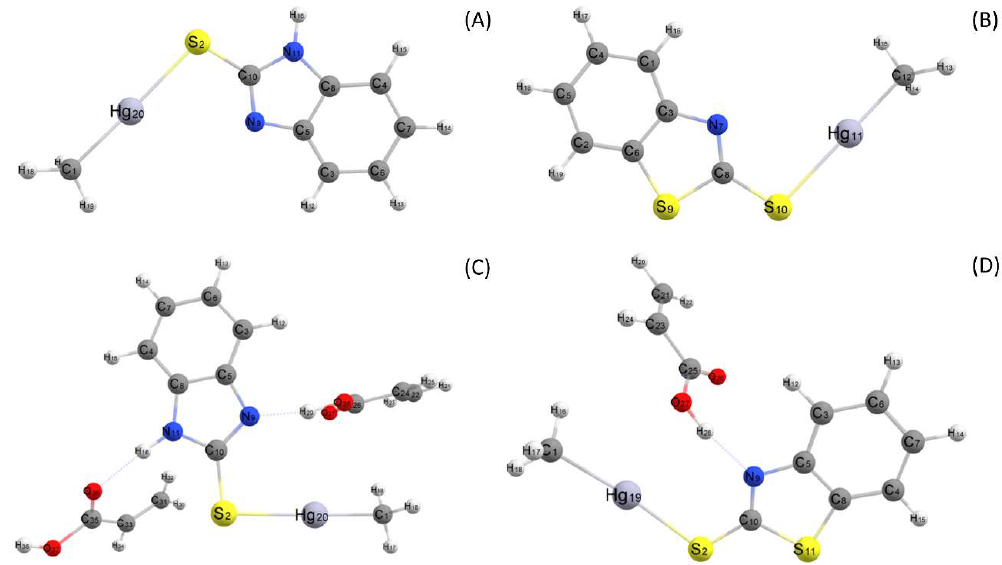
Figure 2. Geometryoptimizationofmethylmercury(MeHg + )–MBI( A )andMeHg + –2-mercaptobenzothiazole Figure 2. Geometry optimization of methylmercury (MeHg + )–MBI ( A ) and MeHg + –2- (MBT) ( B ) in ethanol (EtOH), and optimized geometries of the pre-polymerization step of MeHg + –MBI ( C ) mercaptobenzothiazole (MBT) ( B ) in ethanol (EtOH), and optimized geometries of the pre- and MeHg + –MBT ( D ) complexes with acrylic acid (AA) as the functional monomer polymerization step of MeHg + –MBI ( C ) and ( B ) MeHg + –MBT ( D ) complexes with acrylic acid (AA) as the functional monomer (FM).